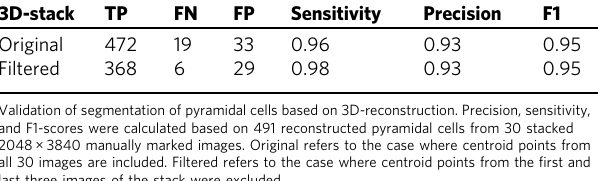
Table 2. In general, individual models for each subject performed well with sensitivity, accuracy, and F1-score above 0.8.